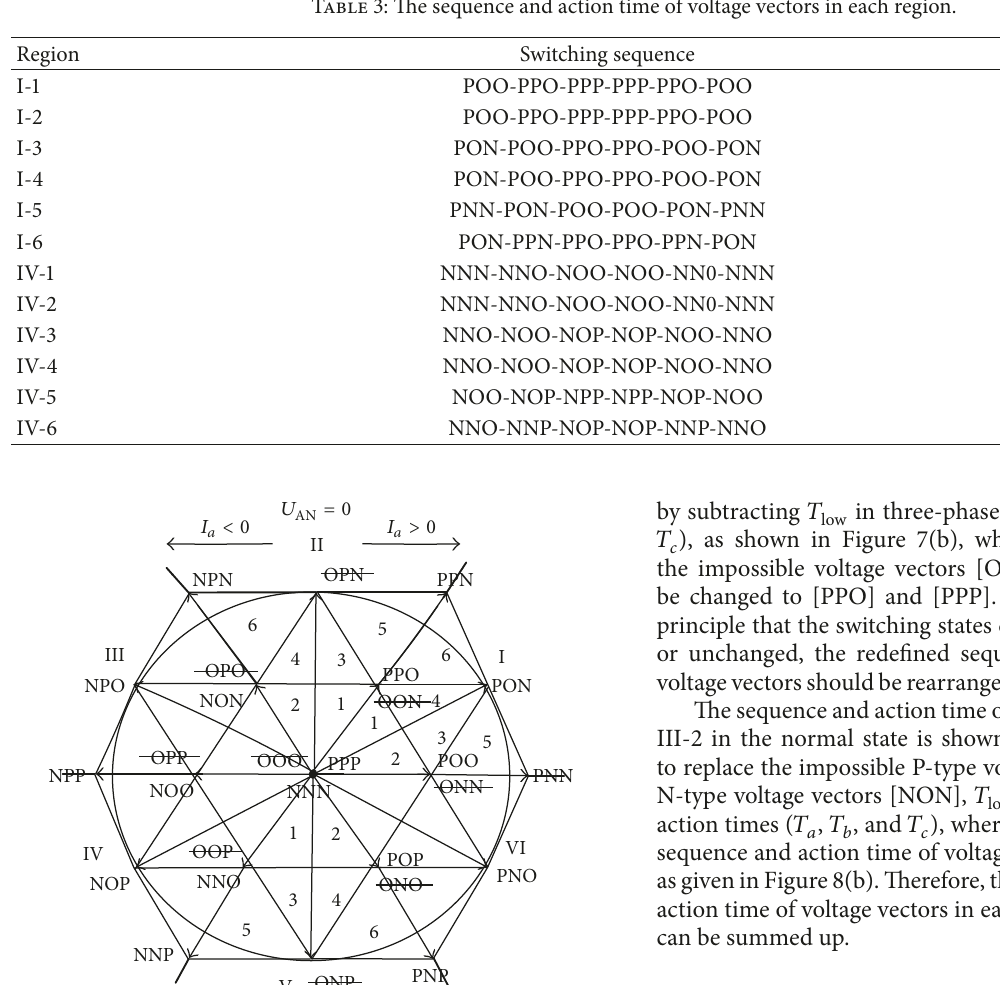
Table 3: The sequence and action time of voltage vectors in each region.